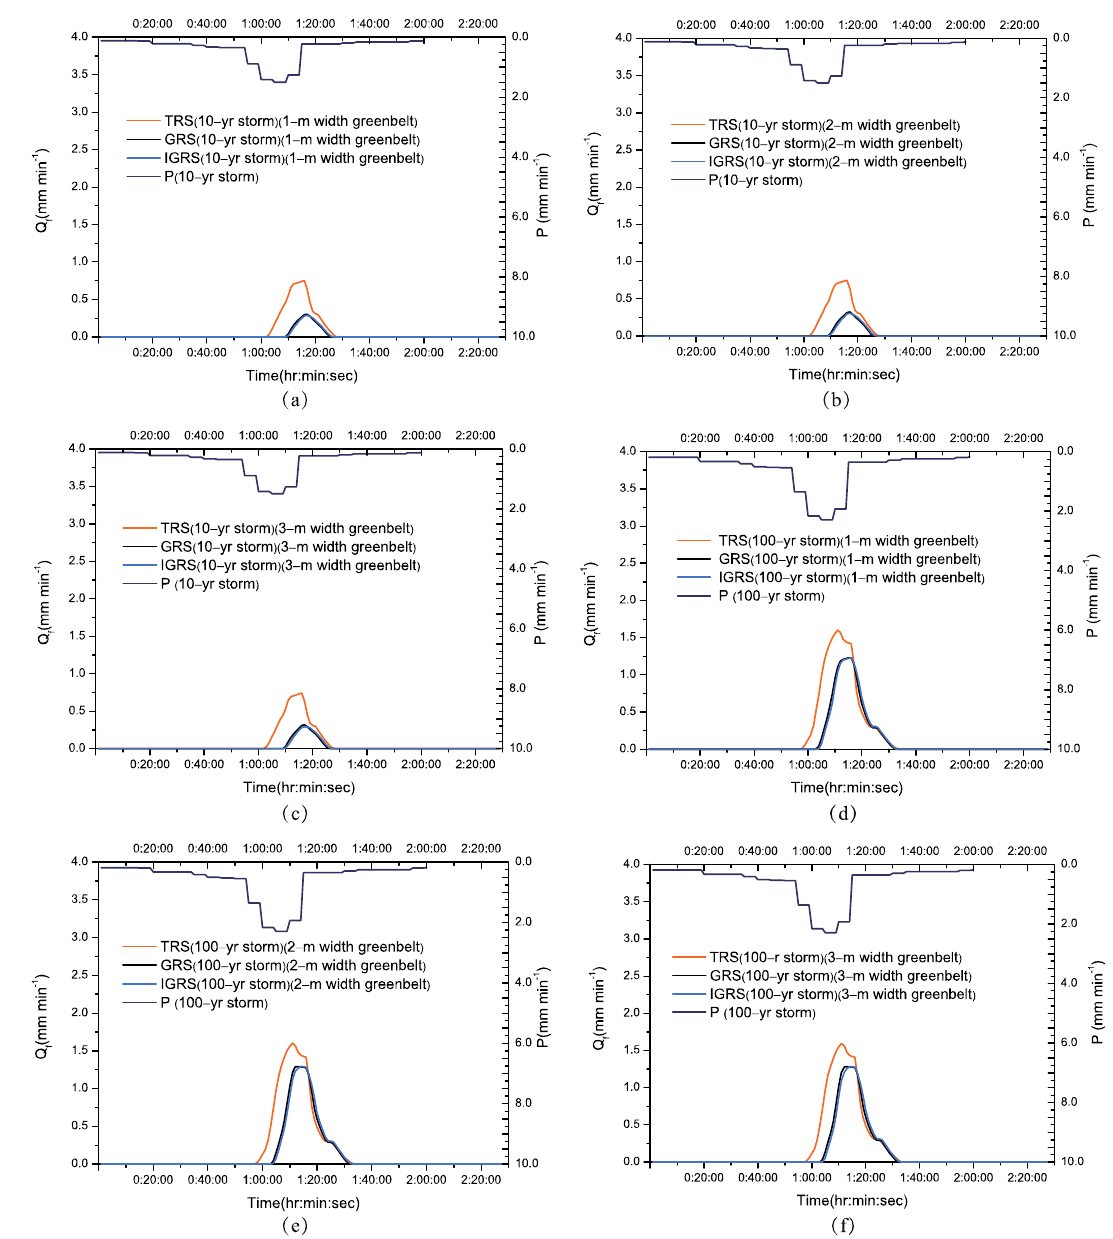
Figure 11. Comparison of flooding flow among the GRS, IGRS, and TRS for 2 single precipitation events (10-yr and 100-yr). ( a ) 10-yr storm (1-m width greenbelt); ( b ) 10-yr storm (2-m width greenbelt); ( c ) 10-yr storm (3-m width greenbelt); ( d ) 100-yr storm (1-m width greenbelt); ( e ) 100-yr storm (2-m width greenbelt); ( f ) 100-yr storm (3-m width greenbelt).